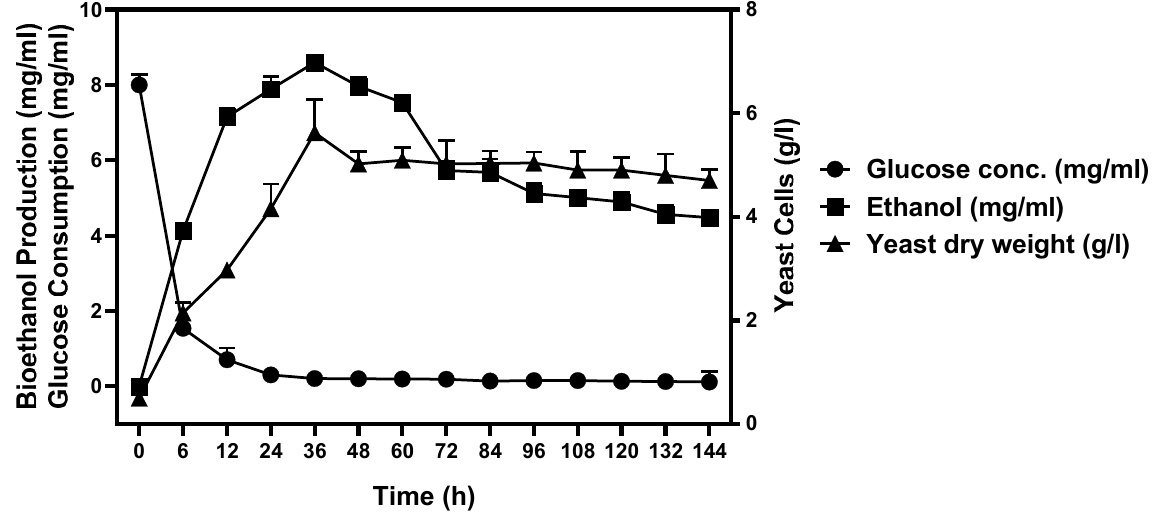
Figure 13. Batch fermentation profile for bioethanol production through locally isolated Starmerella bacillaris (STDF-G4) using cellulosic fiber waste in a bench-scale bioreactor.